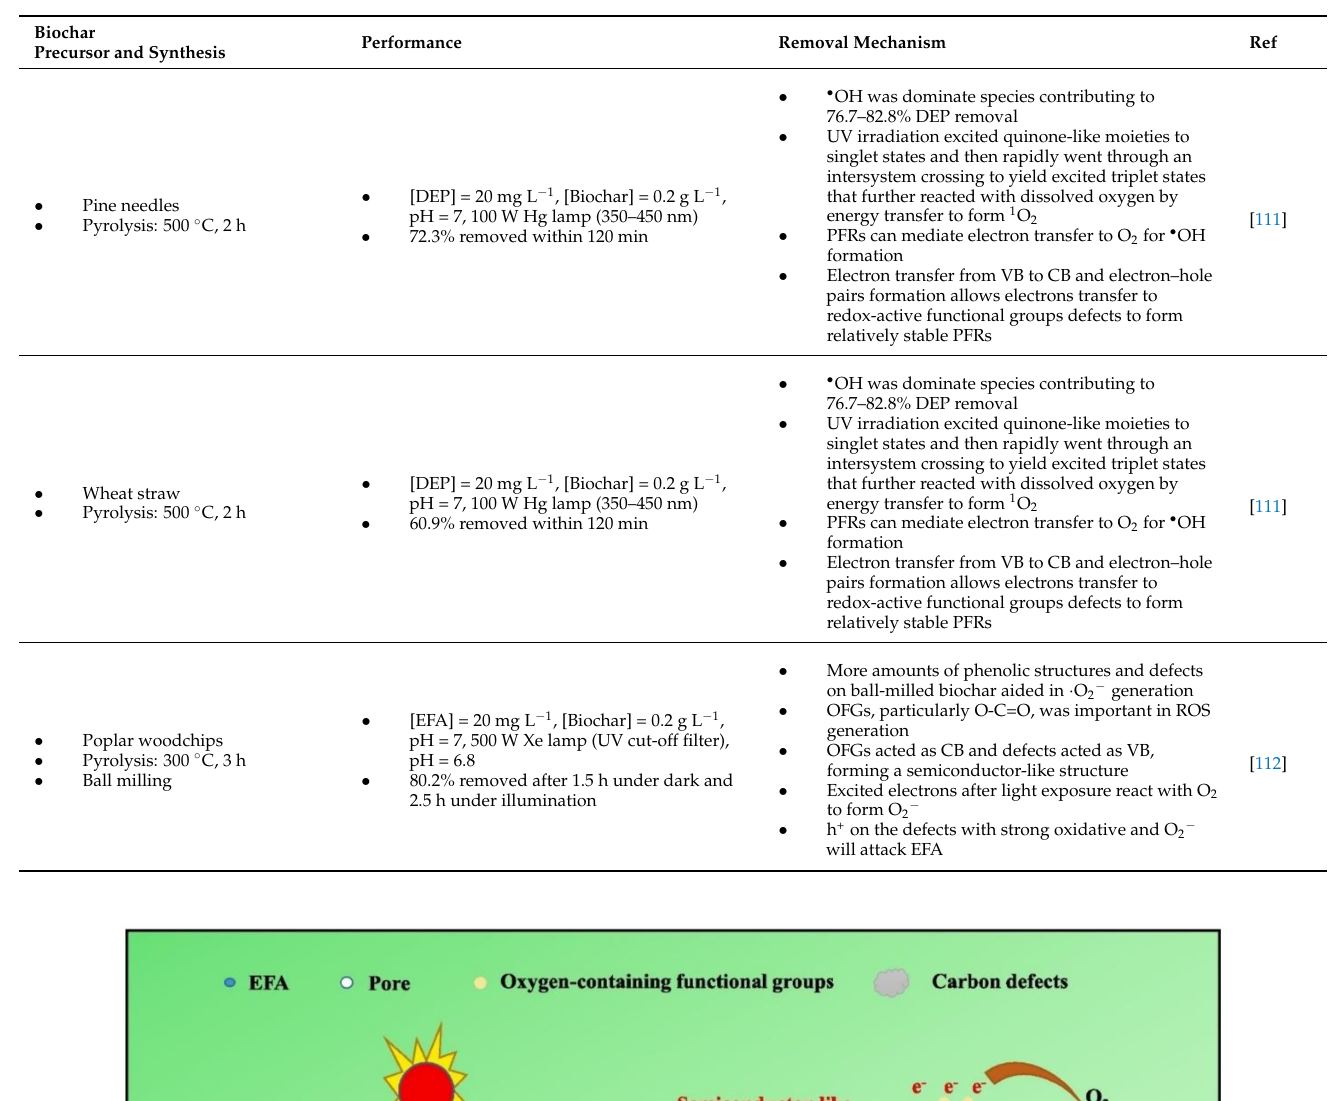
Table 5. An overview of biochar preparation and performance as photocatalyst activation for organic pollutants removal.